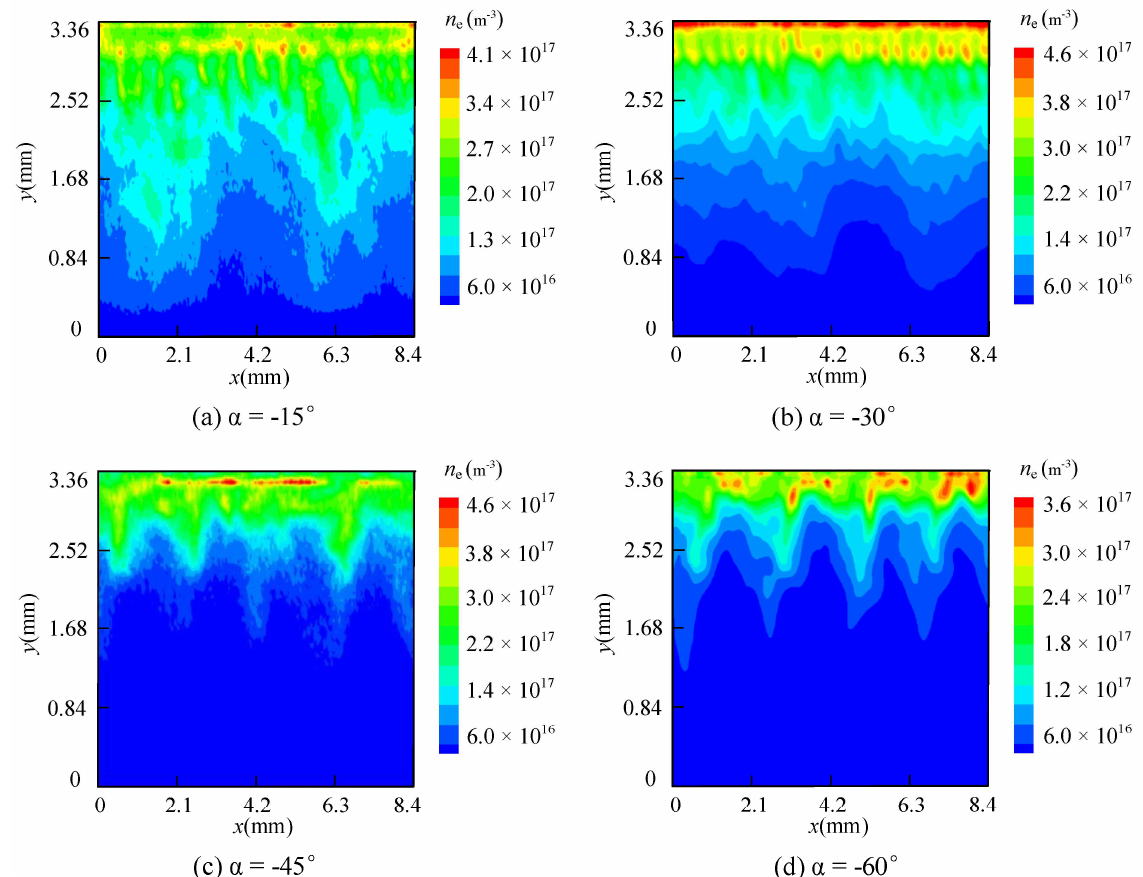
Figure 12. The 2D distributions of electron density with different values of the negative α .